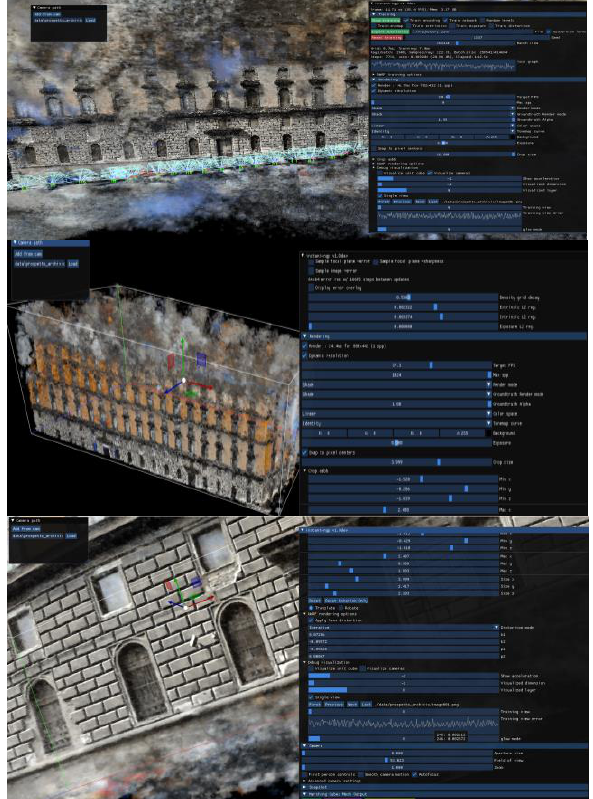
Figure 3 . The Nerf survey of the façade of Santi Severino in Naples.